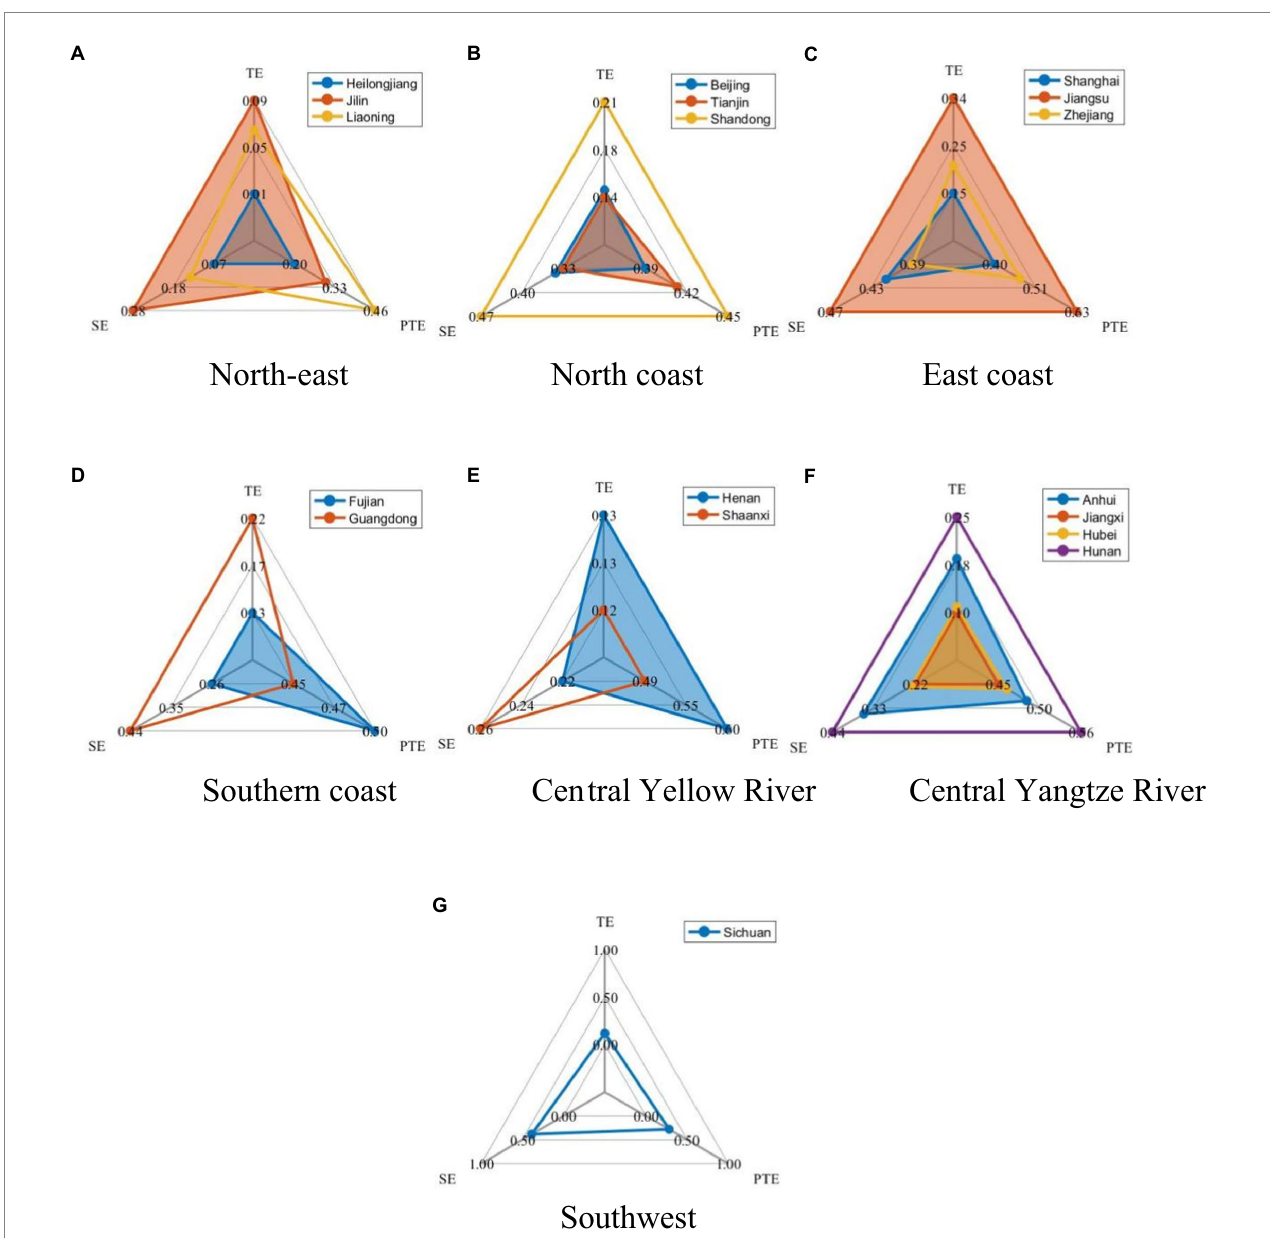
FIGURE 7 Three-stage DEA comparison by region. (A) North-east. (B) North coast. (C) East coast. (D) Southern coast. (E) Central Yellow River. (F) Central Yangtze River. (G) Southwest.